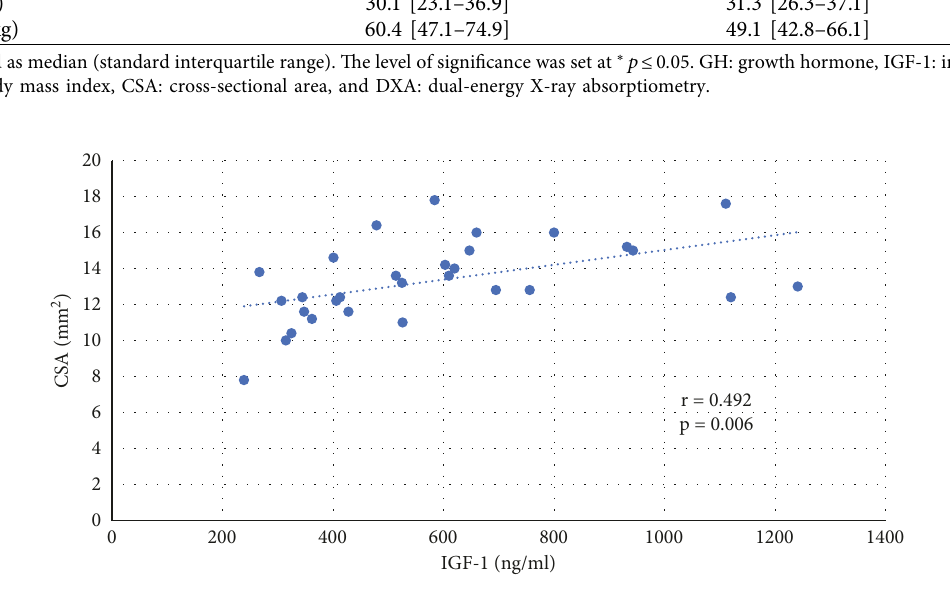
Figure 1: Correlation between IGF-1 and CSA of the median nerve in acromegalic patients.